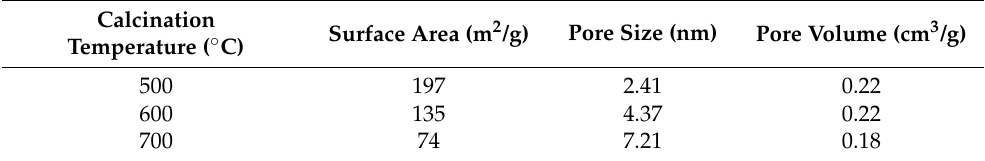
Table 1. Structural properties of solid acid MoZr.